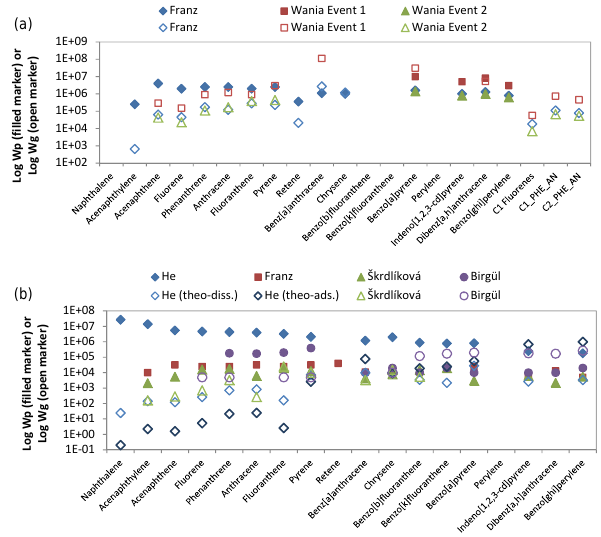
Figure 5. Particle and gas scavenging ratios for (a) snow and (b) rain obtained from the literature (Franz and Eisenreich, 1998; Wania et al., 1999; He and Balasubramanian, 2009; Birgül et al., 2011; Škrdlíková et al., 2011). PHE_AN =